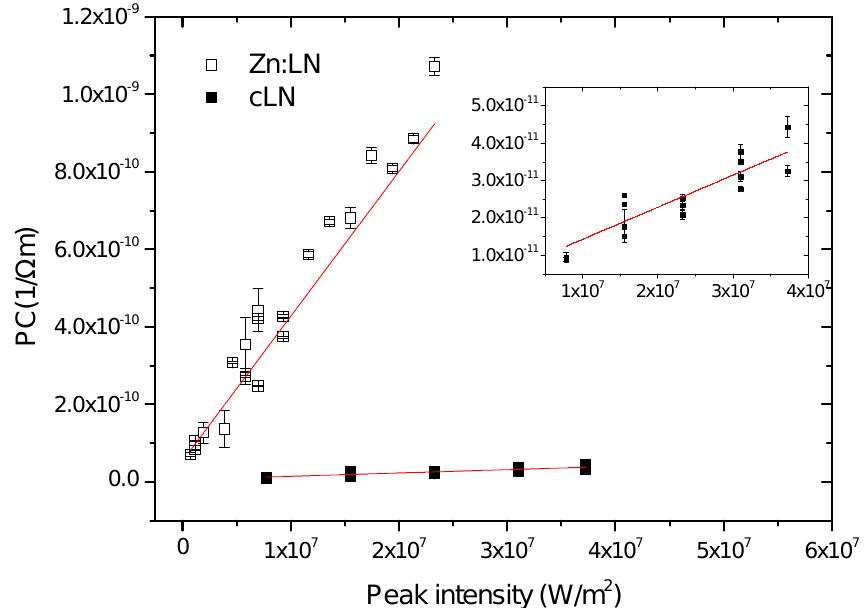
Figure 3. PC as a function of the peak beam intensity in sample cLN and Zn:LN. In the inset a zoomed view of data relative to sample cLN is shown for better clarity. The red lines are linear fits to the experimental